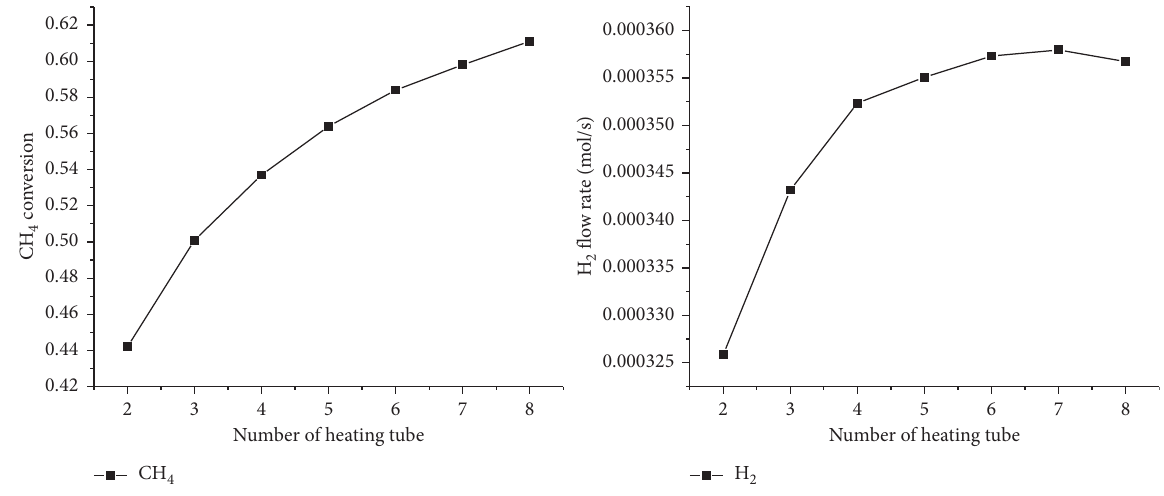
Figure 11: Methane conversion (left) and hydrogen flow rate